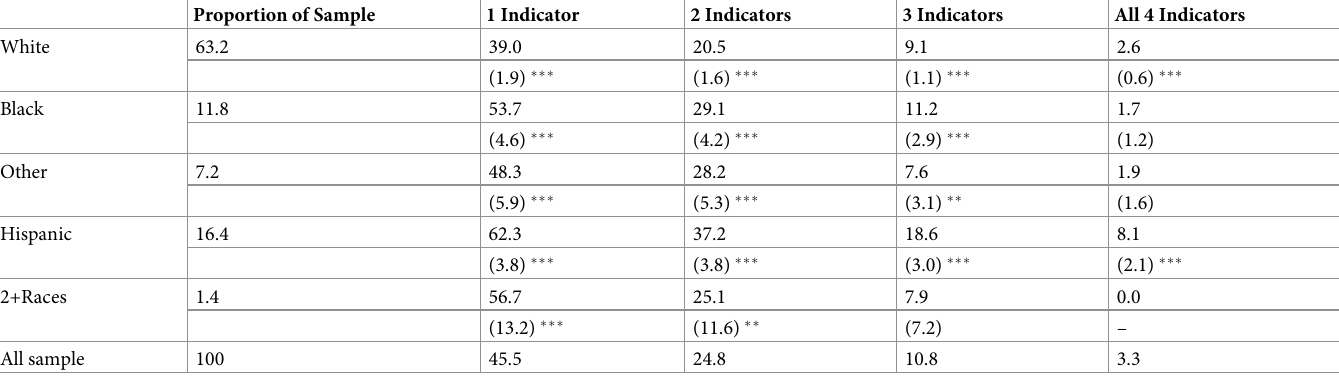
Table 4. Proportion of multidimensional deprived by race and ethnicity. Proportion of